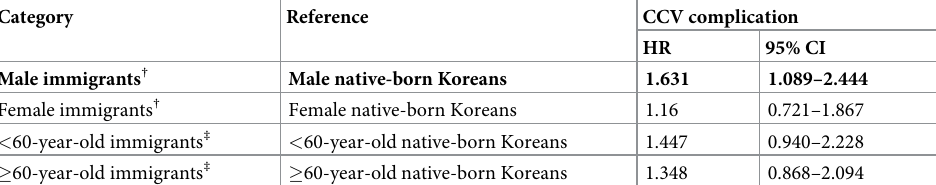
� CCV; Cardio-cerebrovascular, CCI; Charlson Comorbidities Index, MPR; Medication possession rate, USC; Usual